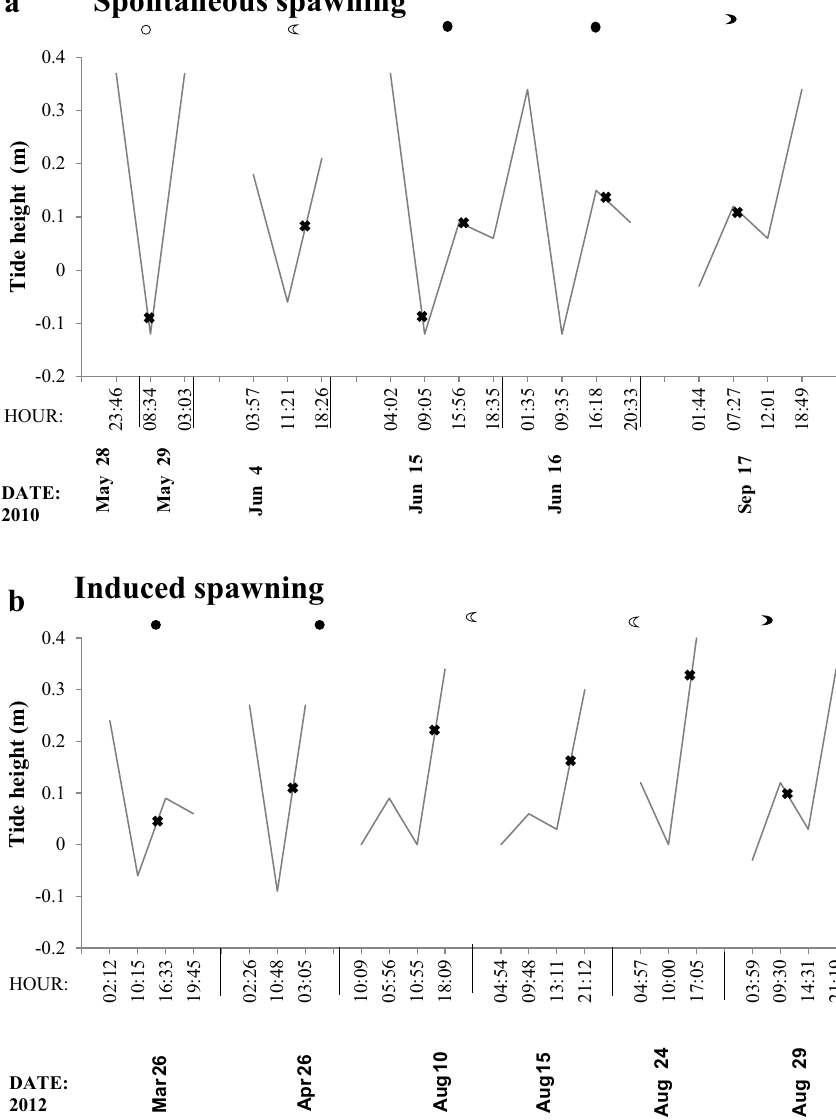
Fig. 1. Cittarium pica . Relationships among the spontaneous and induced spawning of adults recently collected with the tidal height regimen and moon phase in the Santa Marta region, Colombian Caribbean for 2010 and 2012 (IDEAM, 2009, 2011). ○ : New moon, ● : full moon, : waning moon, : crescent